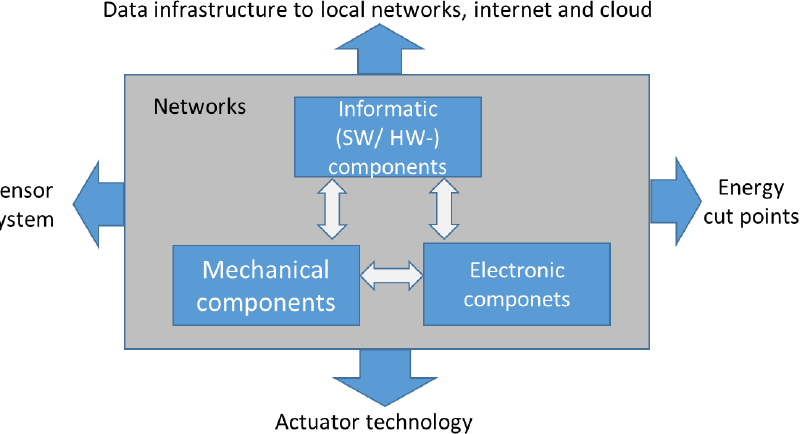
Figure 2. The basic cyber-physical system (CPS). Source: Kai Lucks, Der Wettlauf um die Digital- isierung op. cit. S 202.